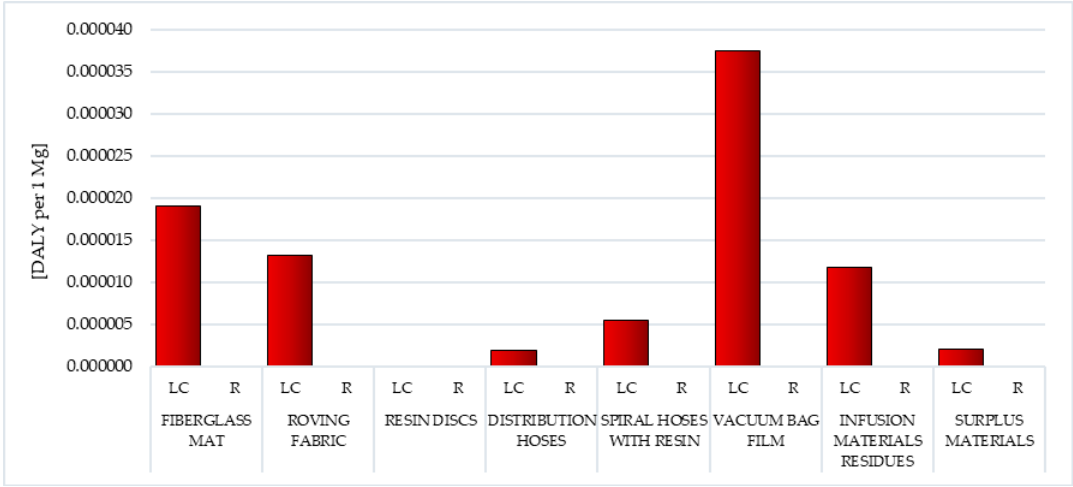
Figure 8. Characterization results of environmental consequences for radioactive substances present in selected postproduction waste of wind power plant blades: LC—life cycle, R—recycling [unit: DALY per 1 mg].